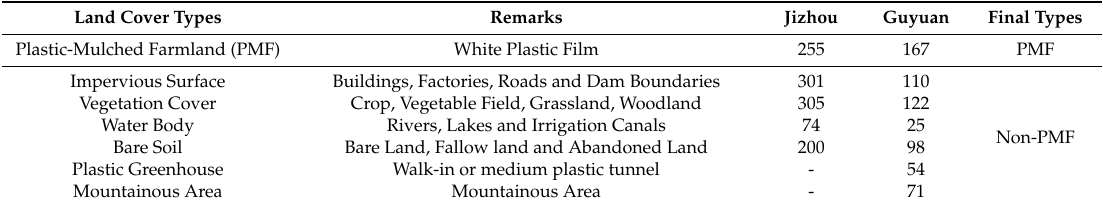
Table 2. The land cover classification scheme and samples in Jizhou and